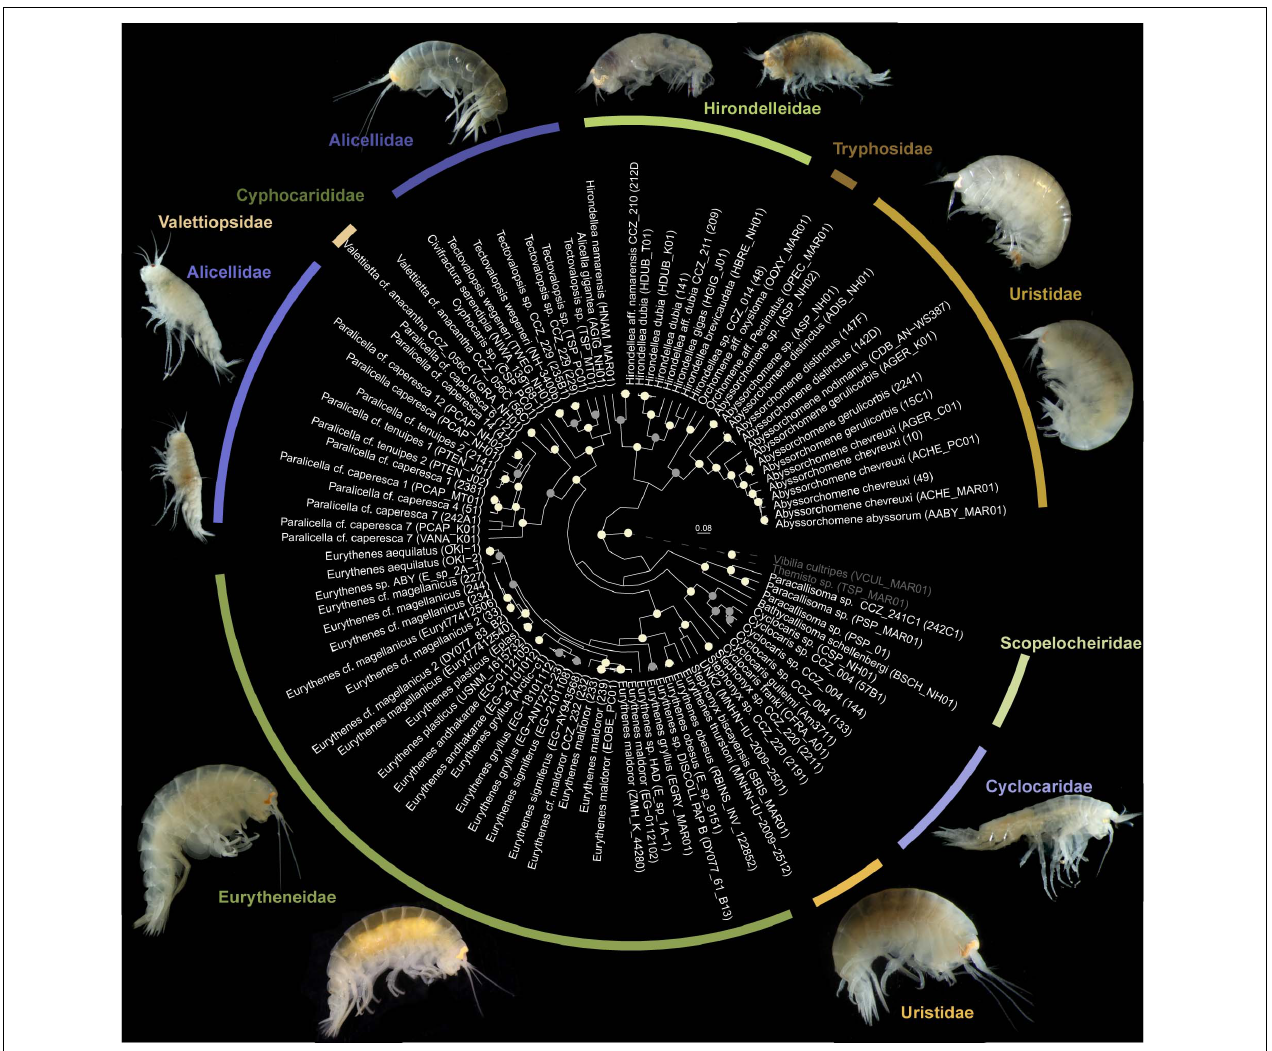
FIGURE 4 | Bayesian phylogenetic tree from a concatenated alignment of the COI, 16S, and 18S genes of the superfamilies Alicelloidea and Lysianassoidea. Only highly supported nodes are highlighted, with posterior support values of 1.0 colored in white and ≥ 0.95 in